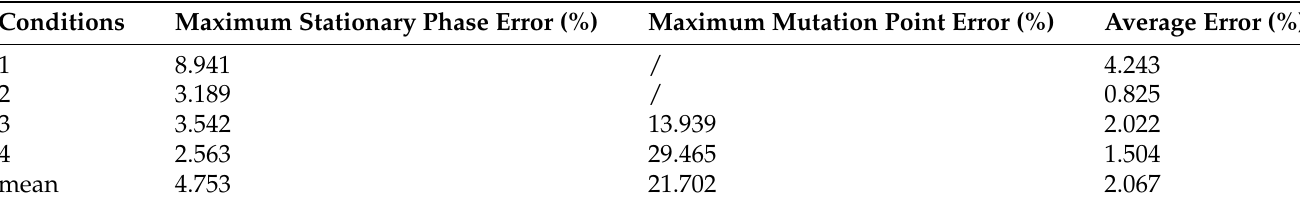
Table 3. Scale experiment error statistical